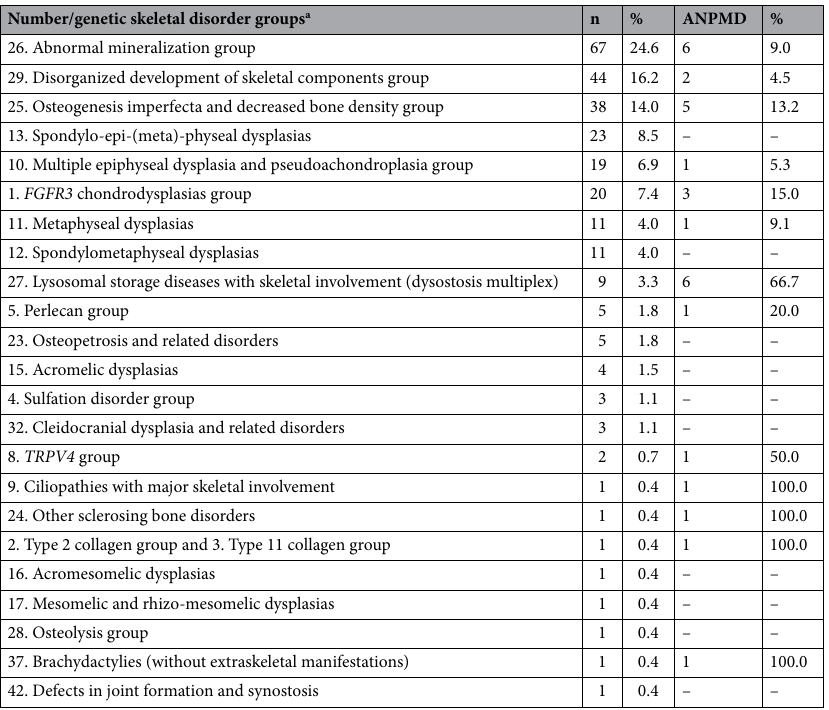
Table 1. Genetic skeletal disorder groups and abnormal neuropsychomotor development frequency. ANPMD abnormal neuropsychomotor development, FGFR3 fibroblast growth factor receptor 3, TRPV4 transient receptor potential action channel subfamily V member 4. a According to the 2019 version of the Classification and Nosology of the ISSD 50